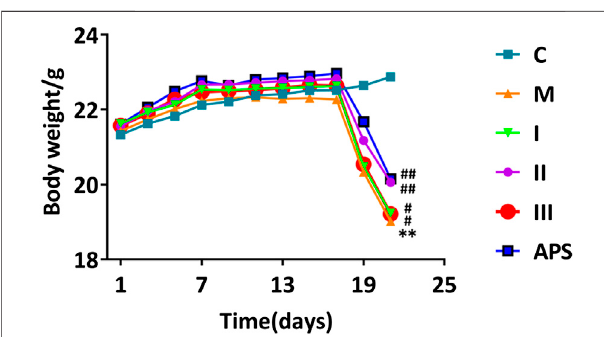
FIGURE 5 | Effect of different APS components on mouse body weight. C:controlgroup,M:modelgroup,I:APS-I,II:APS-II,III:APS-III.n (cid:2) 9, ± s ,* p < 0.05, ** p < 0.01, *** p < 0.001 vs. the control group; # p < 0.05, ## p < 0.01, ### p < 0.001 vs. the model